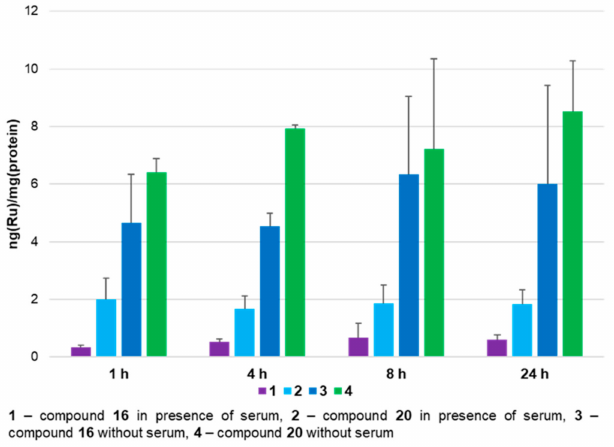
Figure 6. Ruthenium content in MCF7